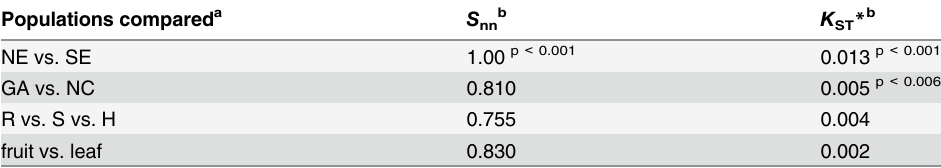
Table 3. Measures of genetic differentiation for populations of Exobasidium maculosum collected from blueberry. Populations compared a S nnb K ST * b NE vs. SE 1.00 p < 0.001 0.013 p < 0.001 GA vs. NC 0.810 0.005 p < 0.006 R vs. S vs. H 0.755 0.004 fruit vs. leaf 0.830 0.002 a Geographic populations consist of isolates from Nova Scotia, Canada and Maine, USA (NE), isolates from the southeastern USA (SE), and isolates from Georgia (GA) and North Carolina (NC). Comparison of populations based on host species within SE include: V . virgatum or rabbiteye blueberry (R), V . corymbosum hybrid or southern highbush blueberry (S), V . corymbosum or highbush blueberry (H). Comparison of populations based on host tissue within SE include fruit spots and leaf spots * calculated in DnaSP (28). Values that signi fi cantly differ from neutrality ( P (cid:3) 0.05) based on b S nn and K ST 1000 permutations of the data are indicated